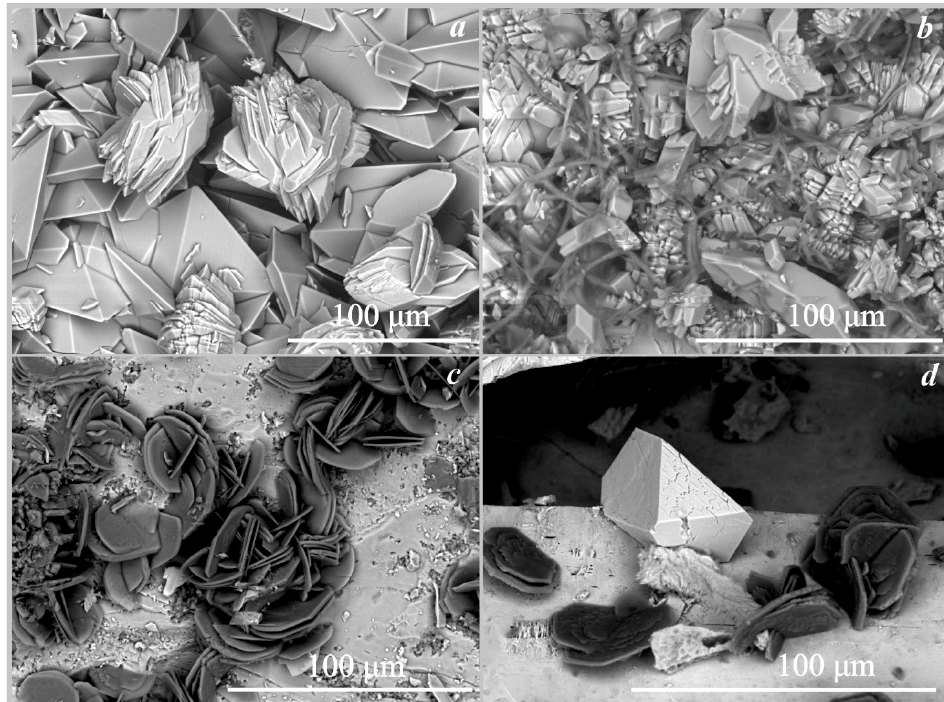
Figure 5. SEM images of the oxalate crystals formed under the action of Serpula lacrymans : ( а )—weddellite and whewellite on marble; ( b )—whewellite on marble (under the action of Antrodia xantha ); ( c )—whewellite on fluorapatite; ( d )—anhydrous lead oxalate and whewellite on cerussite.